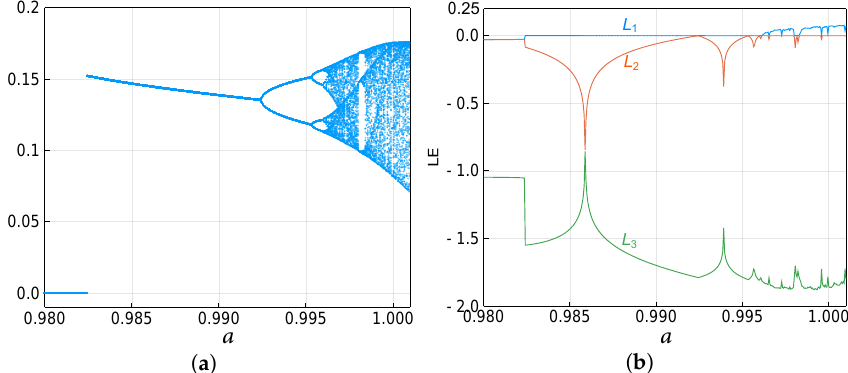
Figure 5. ( a ) Bifurcation diagram, and ( b ) Lyapunov exponents spectrum versus a of system (25).